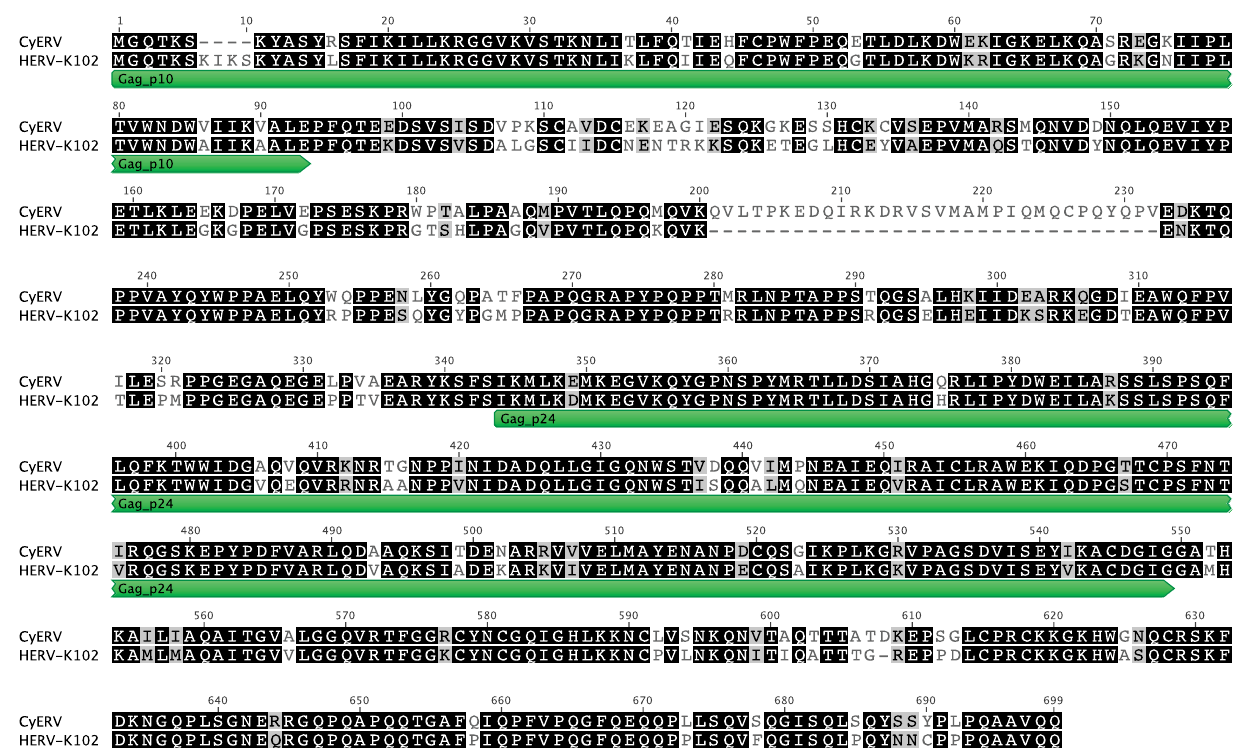
Figure 1. Amino acid alignment of CyERV gag with HERV-K102 gag. The protein sequence of CyERV gag (GenBank: JN985533) was aligned with HERV-K102 (GenBank: P63130) using ClustalW and shaded using Geneious Pro 5.4.6 [31]. HERV-K102 is annotated with the matrix protein (Gag_p10) and the nucleocapsid protein (Gag_p24). Black shading indicates identical residues found at both sites amongst the aligned proteins and grey shading indicates similar amino acid residues.